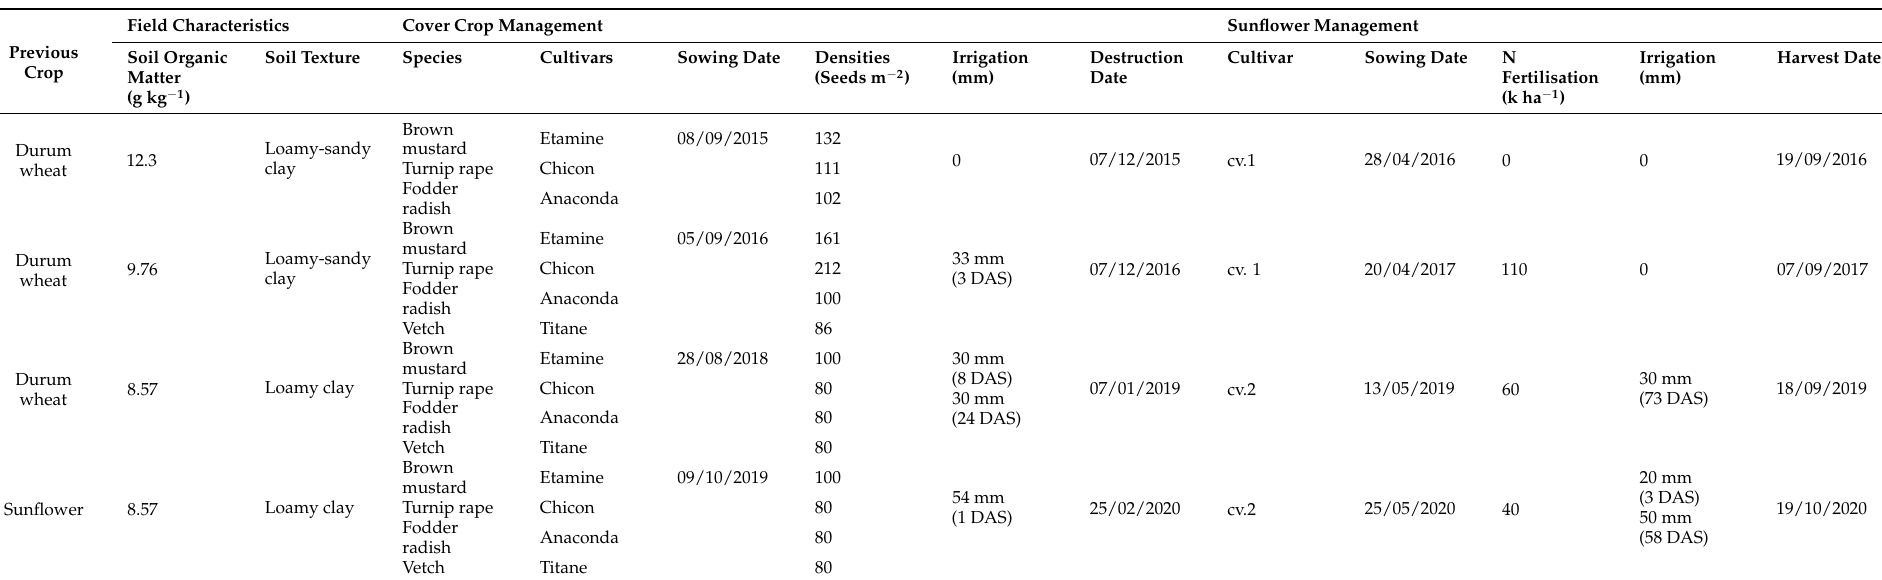
Table 1. Field characteristics and crop management for the cover crops and the sunflower of the four-year experiment carried out at Auzeville, France. Cover crops were sown after a previous crop in 2015, 2016, 2018 and 2019, and the destruction was performed close to the flowering of the Brassicaceae. Sunflower cultivar (cv. 1 or cv. 2) were sown after cover crops destruction in 2016, 2017, 2019 and 2020. Irrigation and N fertilisation are for the growing season measurements from the sowing date to the date of cover crop destruction or sunflower harvest. DAS is for days after